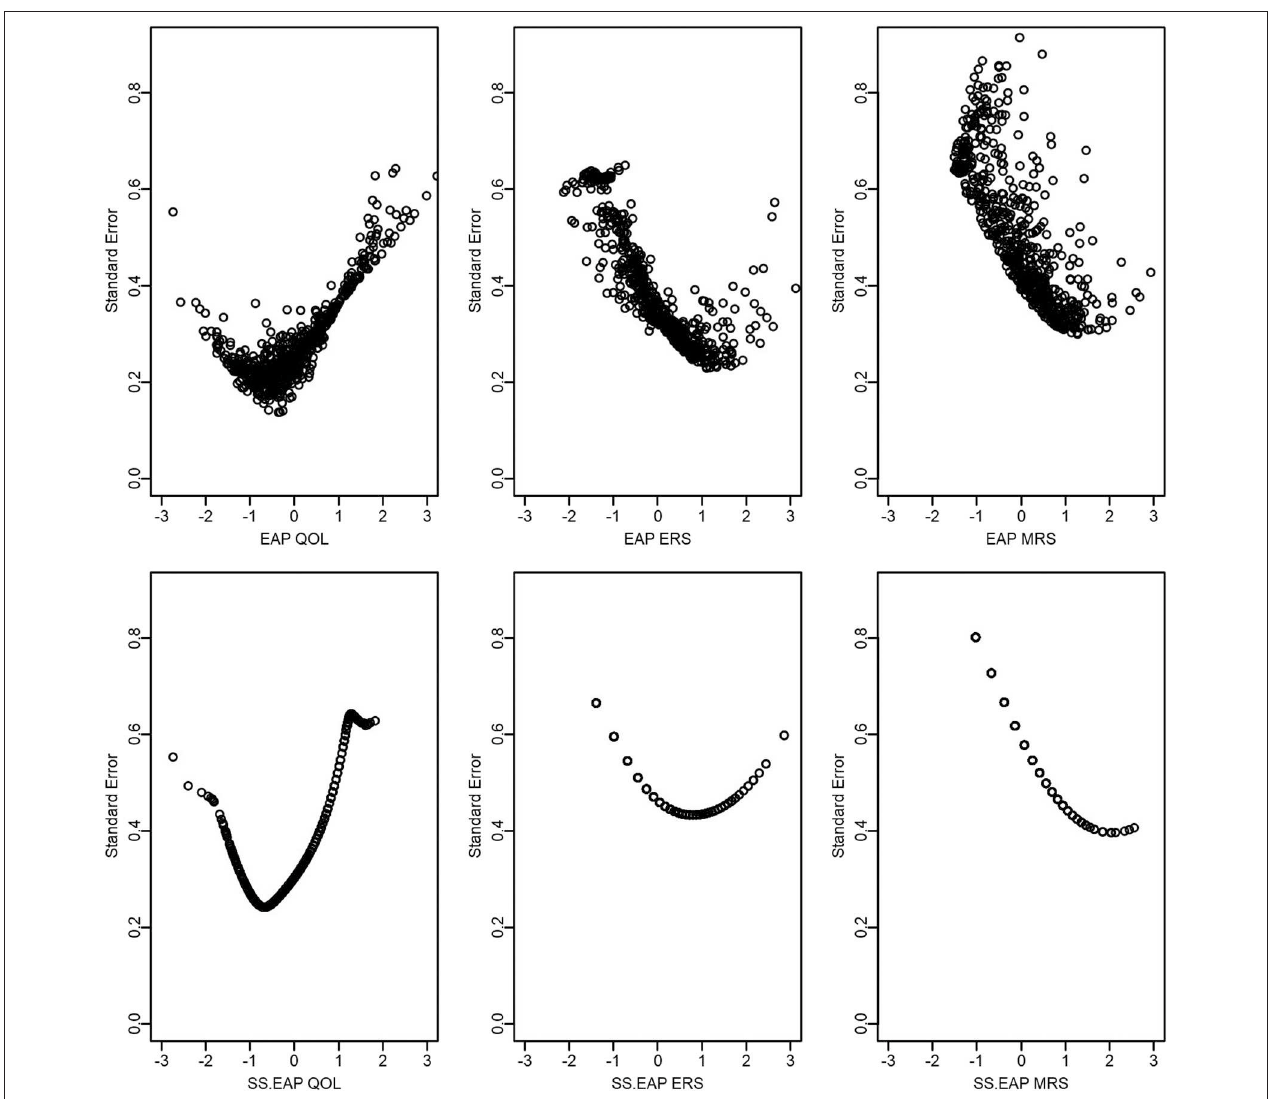
FIGURE 6 | Scatter plots of QOL, ERS, and MRS scores and standard